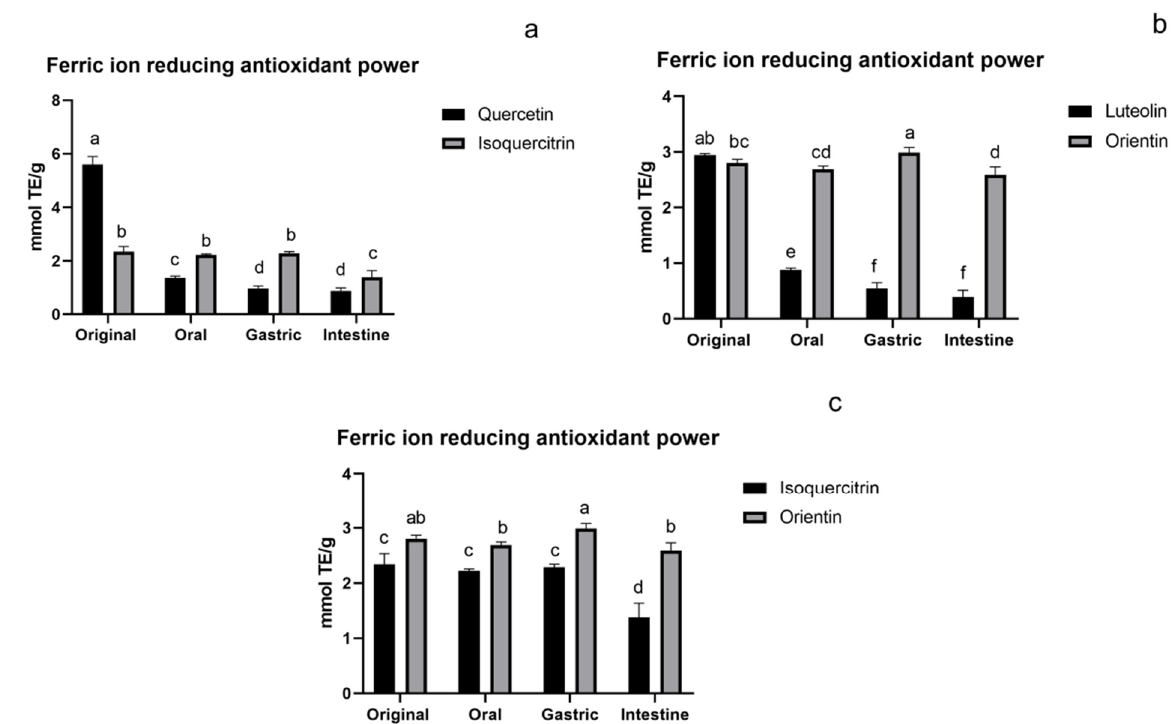
Figure 4. FRAP assay of flavonoids: ( a ) flavonoid O-glycoside and its aglycone, ( b ) flavonoid C-glycoside and its aglycone, and ( c ) flavonoid O-glycoside and flavonoid C-glycoside. The results are reported as means ± SD. Different letters in the figure indicate significant differences ( p < 0.05).